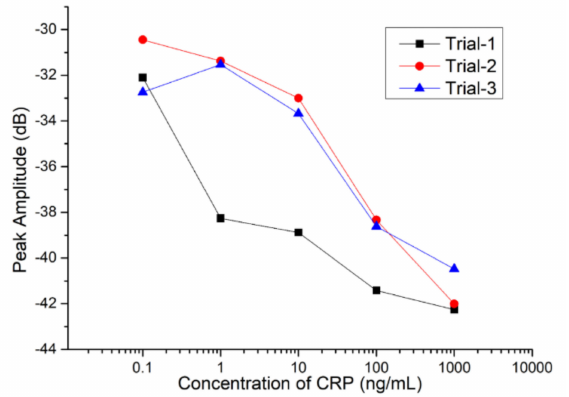
Figure 7. The amplitude response of SAW sensor for measurements taken three times for each CRP